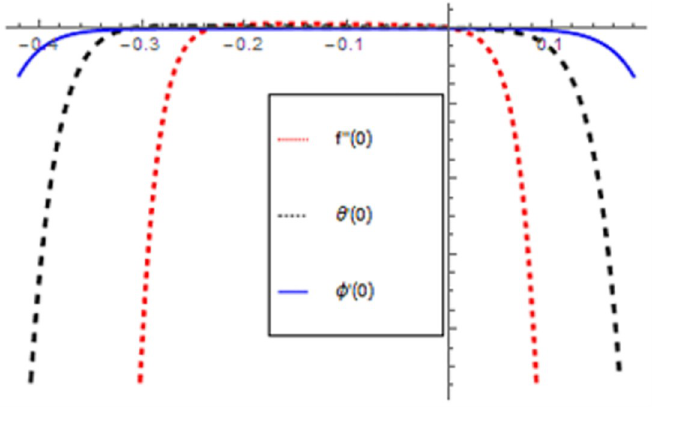
Fig 2. ℏ –curves for f 0 ( ξ ), θ ( ξ ) and ϕ ( ξ